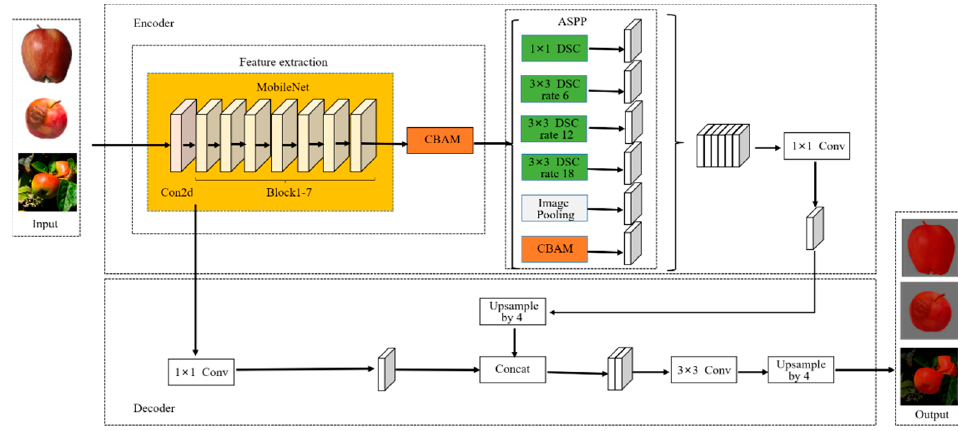
Figure 1. Structure of DeepMDSCBA method.